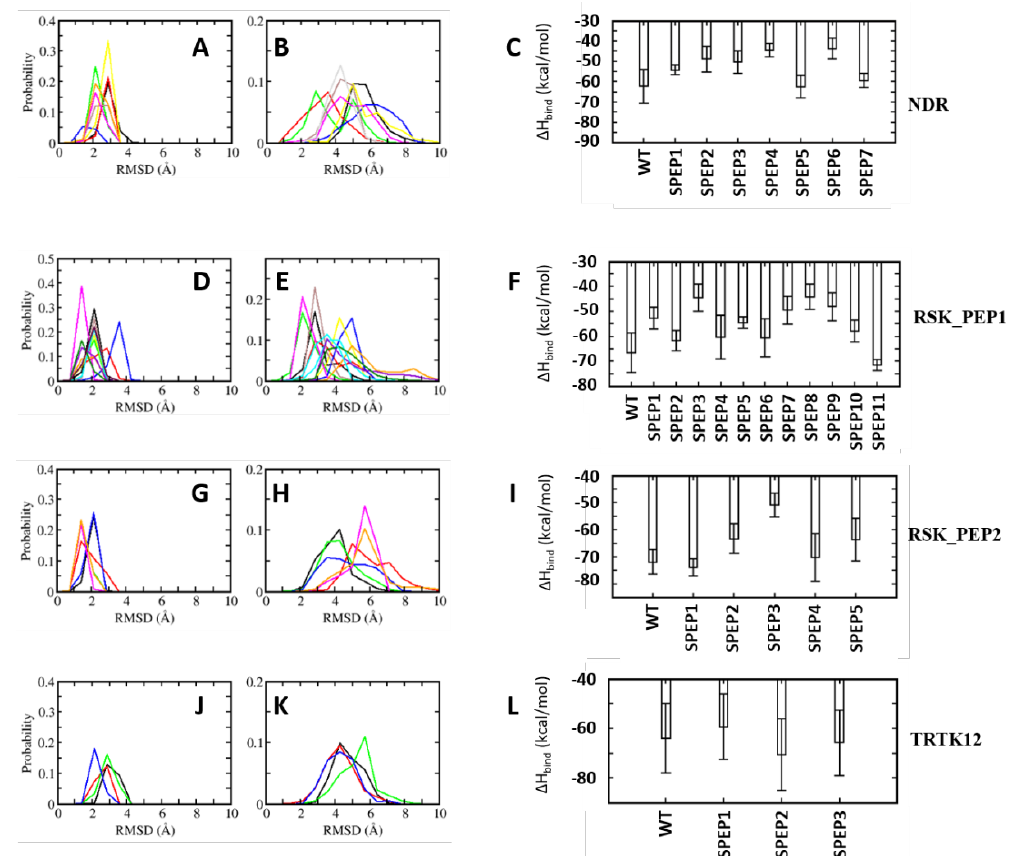
Figure 8. Distribution of root mean squared deviations (RMSD) of ( A , D , G , J ) S100B(ββ) and ( B , E , H , K ) the bound stapled peptides (( A , B ): S100B(ββ)-NDR; ( D , E ): S100B(ββ)-RSK_PEP1; ( G , H ): RSK_PEP2; ( J , K ): S100B(ββ)-TRTK12 complexes). Different colours correspond to different stapled peptides ((NDR: black: WT, red: SPEP1, green: SPEP2, blue: SPEP3, yellow: SPEP4, brown: SPEP5, magenta: SPEP6, grey: SPEP7) (RSK_PEP1: black: WT, red: SPEP1, green: SPEP2F, blue: SPEP3, yellow: SPEP4, brown: SPEP5, magenta: SPEP6, orange: SPEP7, cyan: SPEP8, violet: SPEP9, dark green: SPEP10, turquoise:SPEP11) (RSK_PEP2: black: WT, red: SPEP1, green: SPEP2F, blue: SPEP3, orange: SPEP4, magenta: SPEP5) (TRTK12: black: WT, red: SPEP1, green: SPEP2F, blue: SPEP3)). ( C , F , I , L ) Binding free energies of the interactions of S100B(ββ) with each stapled peptide were calculated with the MMPBSA approach (see Methods) using the conformations sampled during the MD simulations of the S100B(ββ)-stapled peptide complexes.